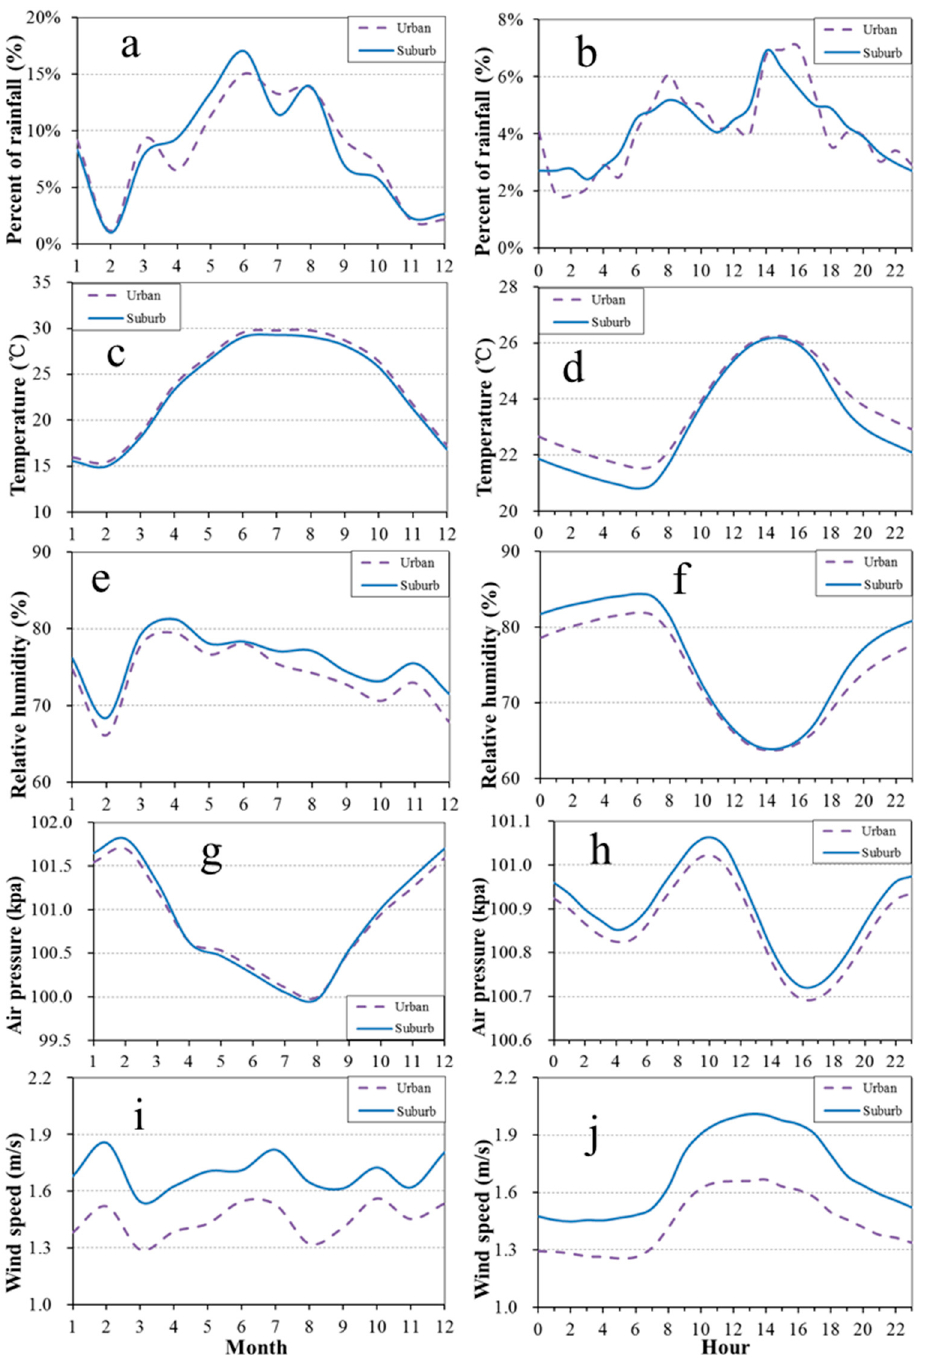
Figure 3. The seasonal (monthly) and diurnal (hourly) distributions of ( a , b ) rainfall, ( c , d ) surface temperature, ( e , f ) relative humidity, ( g , h ) air pressure, and ( i , j ) wind speed at the urban and suburban sites in Guangzhou from July 2015 to October 2017.